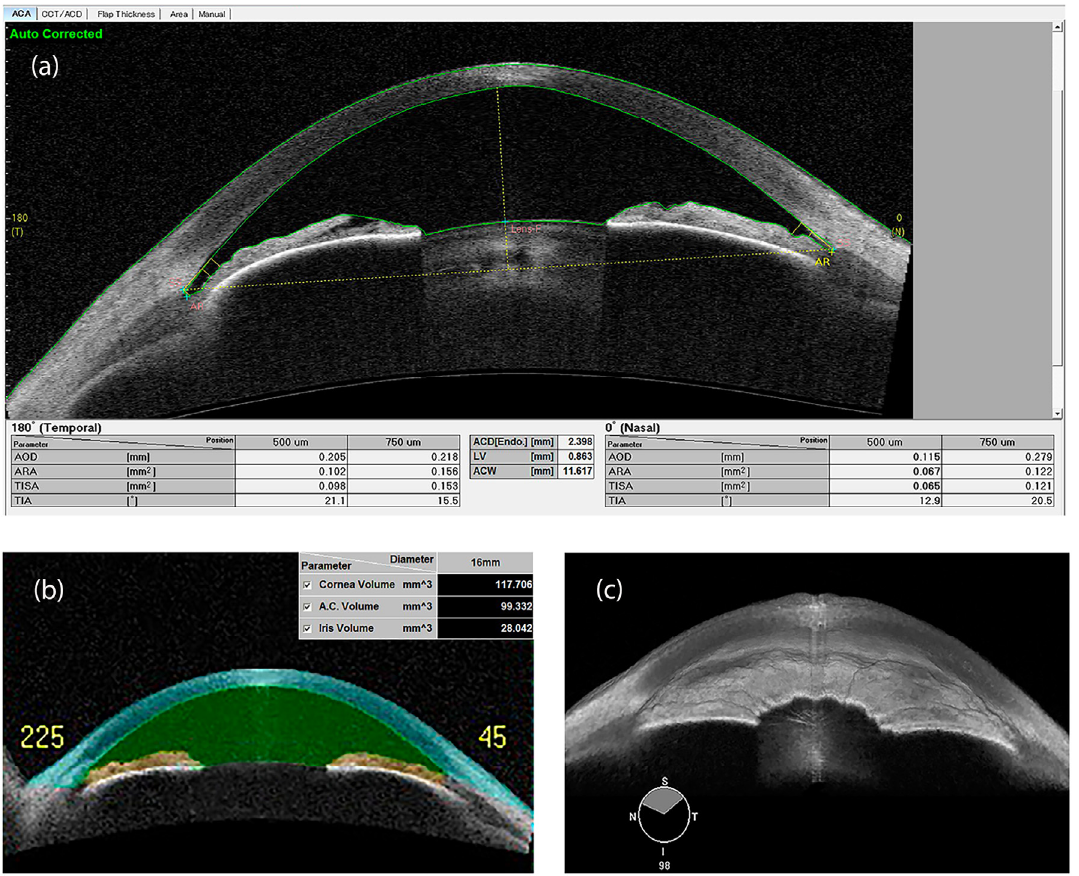
Figure 6. Swept source-OCT image of the anterior chamber, with scleral spur identification and quantitative parameters, in an eye affected with narrow angle and keratoconus ( a ). Anterior chamber volume ( b ) and 3D rendering of a narrow irido-corneal angle ( c ) (swept-source OCT). ACD: Anterior chamber depth; ACW: Anterior Chamber Width; AOD: Angle opening distance; ARA: Angle recess area; LV: Lens vault; TIA: Trabecular-iris angle; TISA: Trabecular-iris space area.